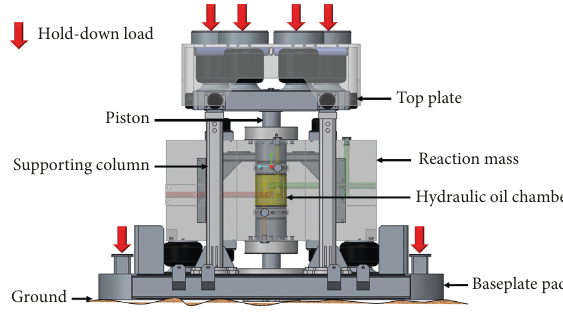
Figure 1: Geometry of the